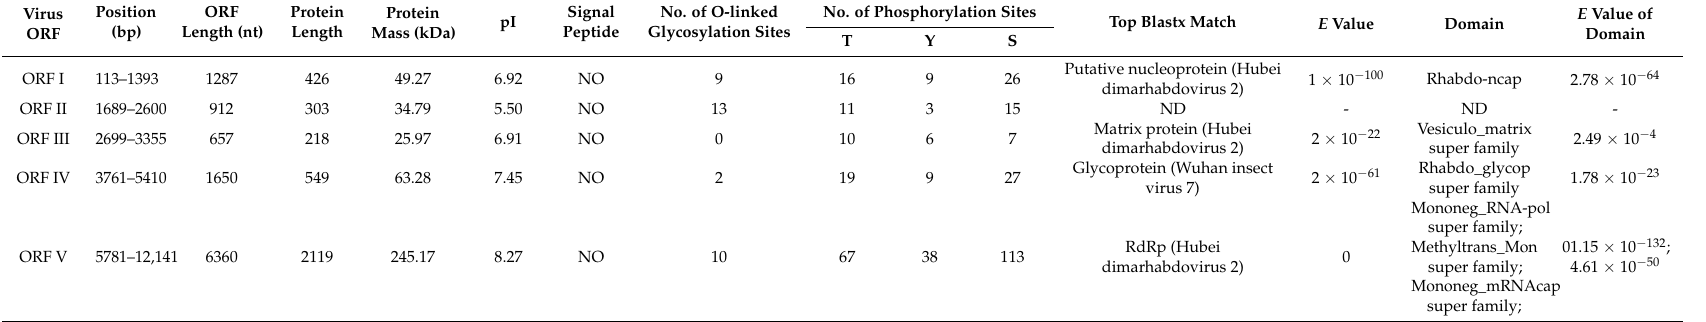
Table 2. Calculated and predicted properties of TbRV-1 ( Tetrastichus brontispae RNA virus 1)